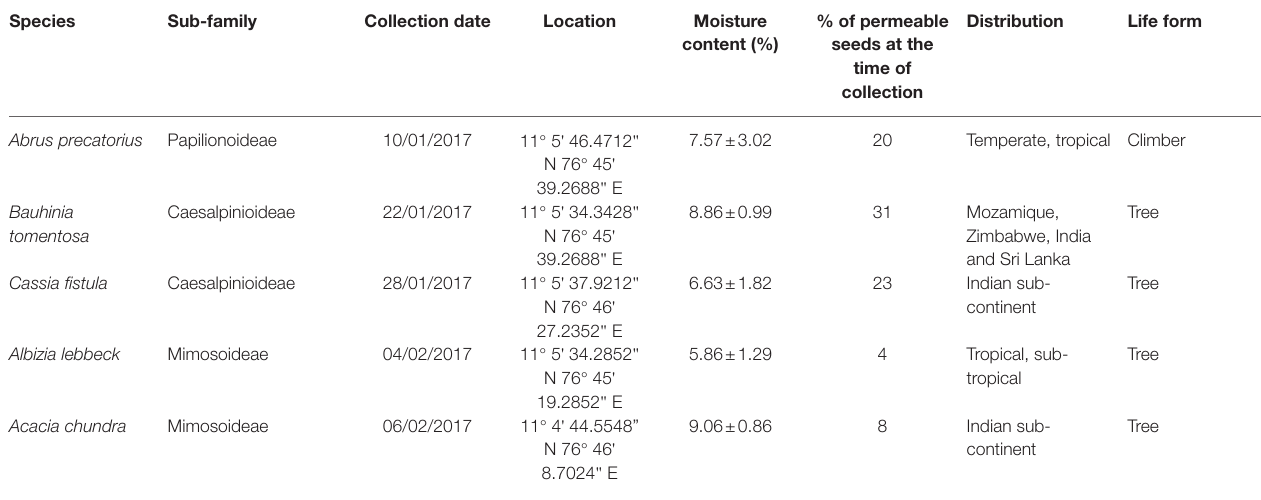
TABLE 1 | The sub-family, collection date, location, moisture content at the time of collection (average ± S.D.), percentage of permeable seeds, and distribution and life form of the five legume species studied.